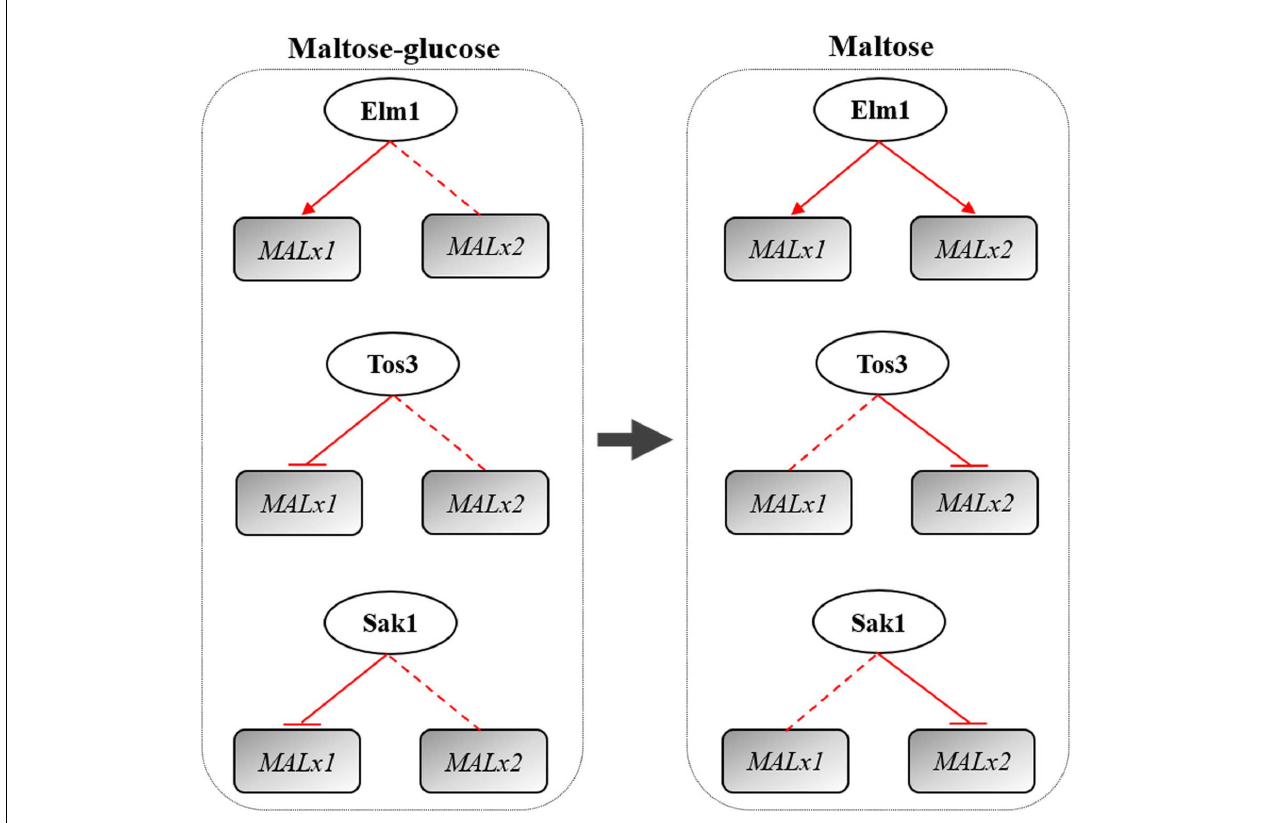
FIGURE 7 | Regulation of the kinases Elm1, Tos3, and Sak1 on MALx1 and MALx2 in maltose-glucose and maltose. x was the locus and MAL3 and MAL6 were analyzed in this study. Red arrow line: positive regulation. Red straight line: native level of the kinase needed. Red flat end line: negative regulation. MALx2 in the regulation of Tos3 in maltose mainly was MAL32 . MALx1 in the regulation of Sak1 in maltose-glucose mainly was MAL31 . MALx2 in the regulation of Sak1 in maltose mainly was MAL32